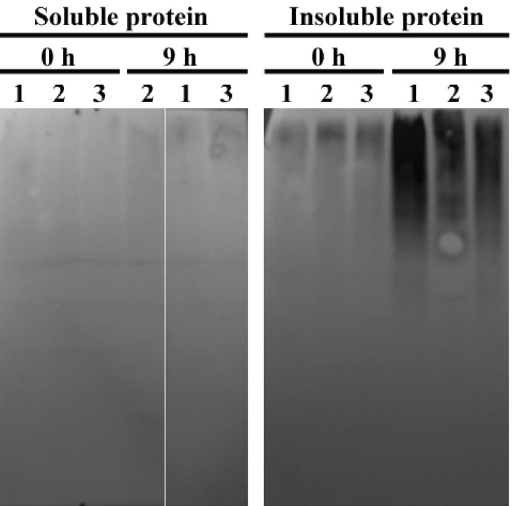
Figure 7. Accumulation of insoluble ubiquitinated proteins in SlCHIP - and SlTPR28 -silenced plants under heat stress. Soluble and insoluble proteins were prepared using low-speed centrifugation from the same amount of total proteins prepared from leaflets of the fourth leaves in SlCHIP -silenced (lane 1), SlTPR28 -silenced (lane 2) and mock (lane 3) plants. The proteins were subjected to SDS-PAGES and probed with anti-ubiquitin monoclonal antibody. The experiment was repeated three times with similar